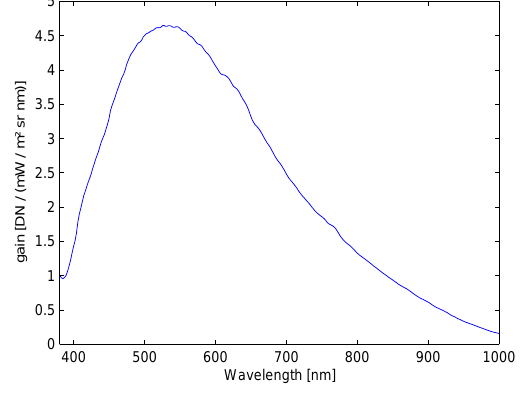
Figure 4: Radiometric calibration coefficient